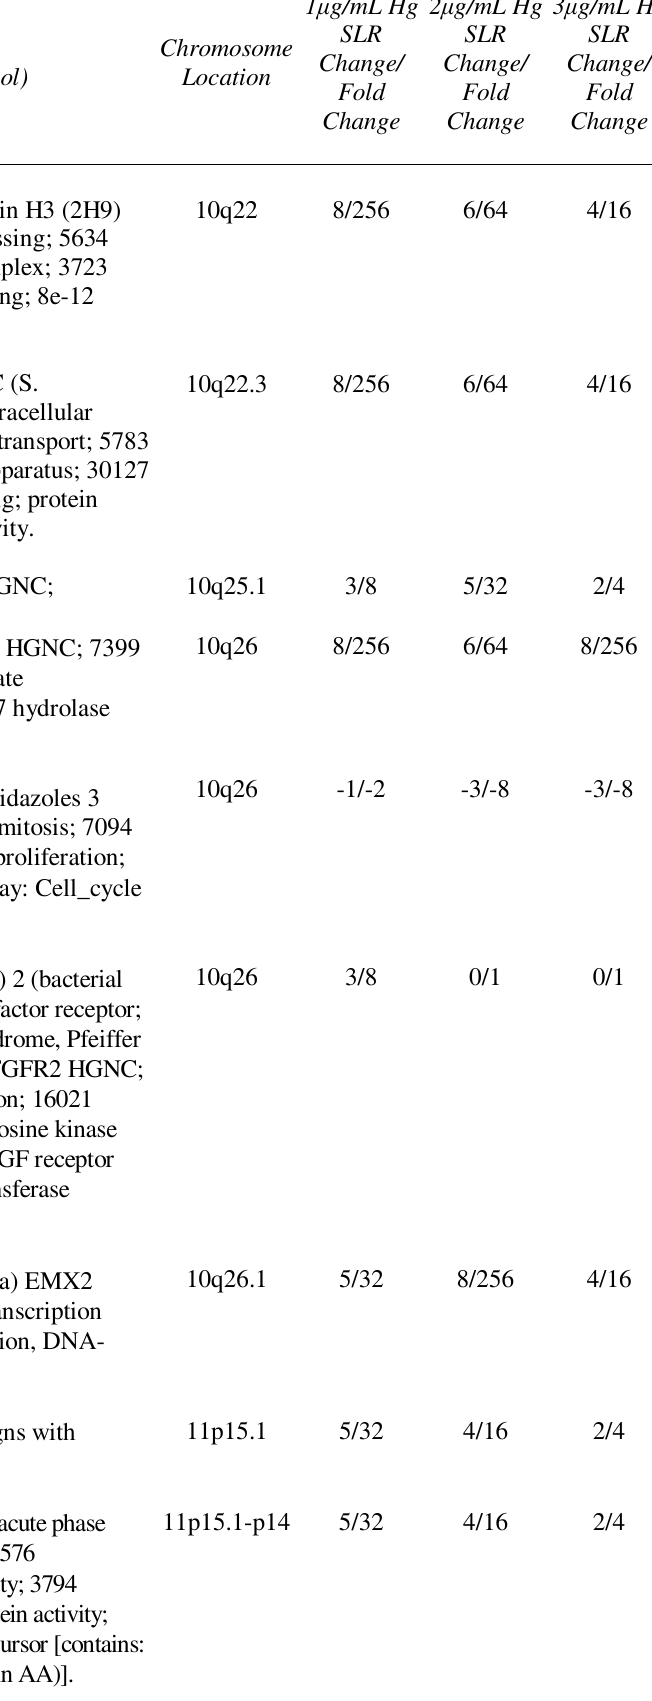
SLR-- signal log ratios